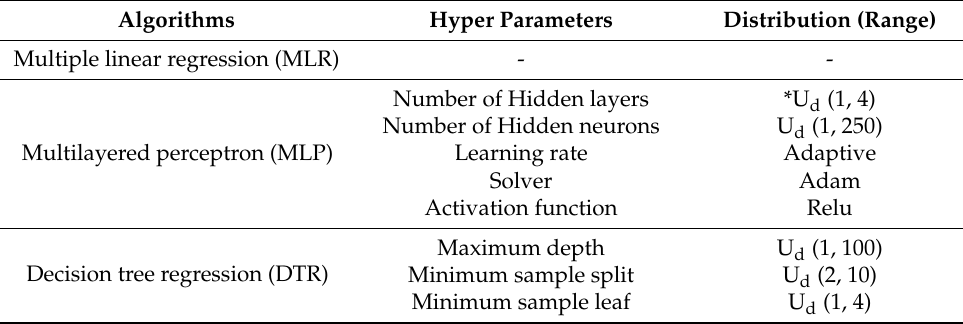
Figure 5. Phase by phase flow chart of the implementation of machine learning models for predicting IAT and IRH. Table 3. The range of critical hyper parameters tuned during the